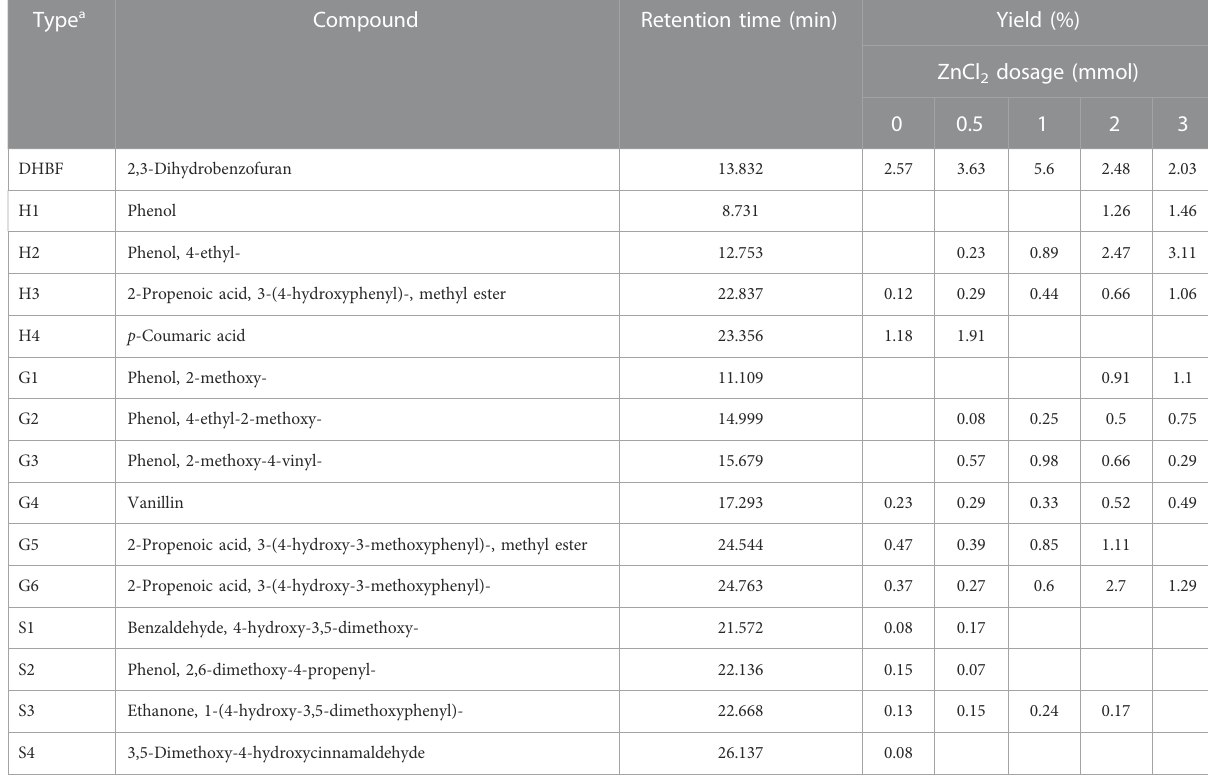
TABLE 2 Effect of ZnCl 2 dosage on the distribution of lignin-derived aromatic monomers.